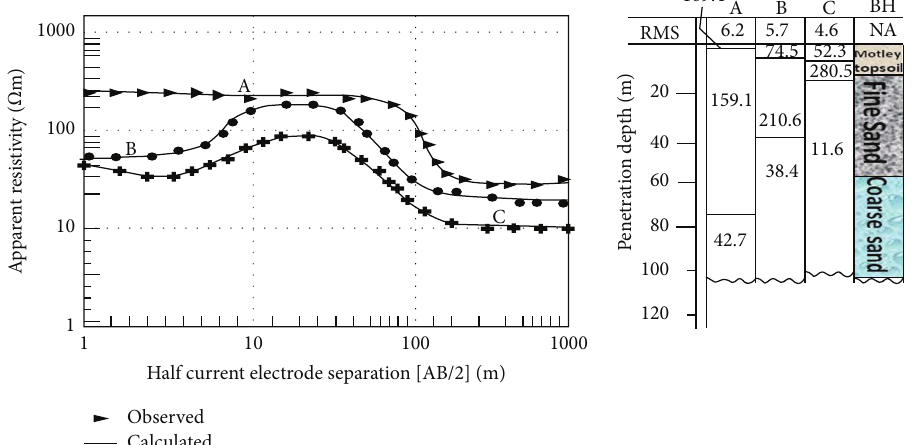
Figure 2: Typical VES curves and modelled results obtained along A-A 1 profile (A Agric. secretariat, B IK. club, and C Local G. Area secretariat).